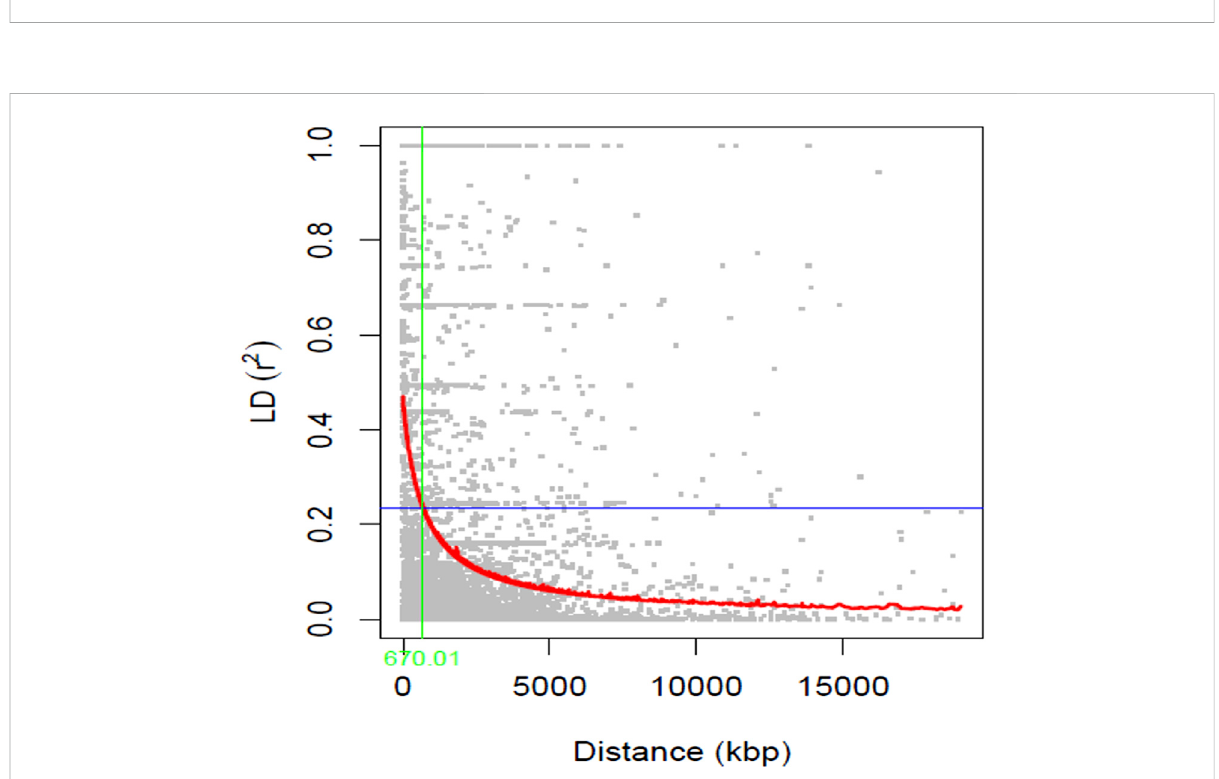
FIGURE 3 Ascatterplot( r 2 values)ofpairwiseSNPsshowinggenome-widelinkagedisequilibrium(LD)decay.Theredcurvelinerepresentsthesmoothing spline regression model fi tted to LD decay. The vertical green line indicates the genetic distance (670 Kbp) at which the LD half-decay ( r 2 = 0.24, the horizontal blue line) intersect with the LD decay